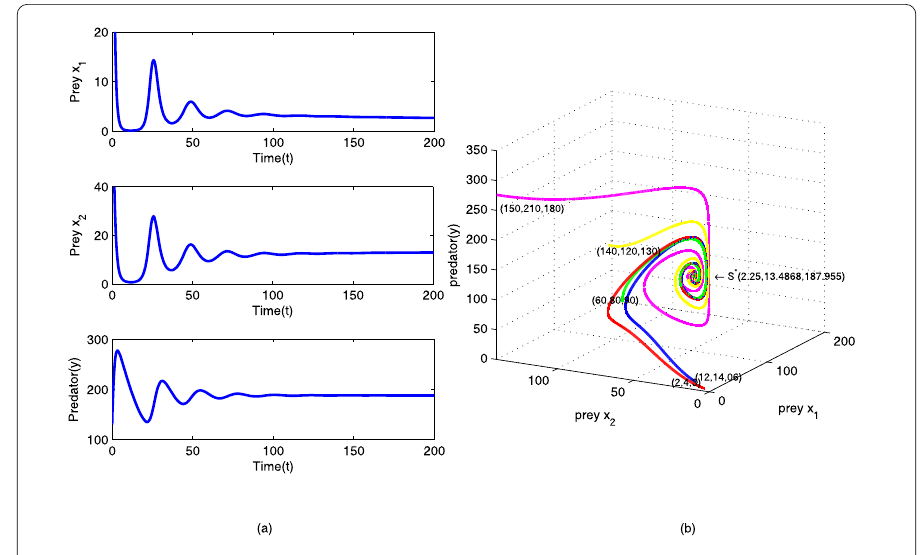
Figure 6 Numerical simulation of model (2.1) around the interior equilibrium point S ∗